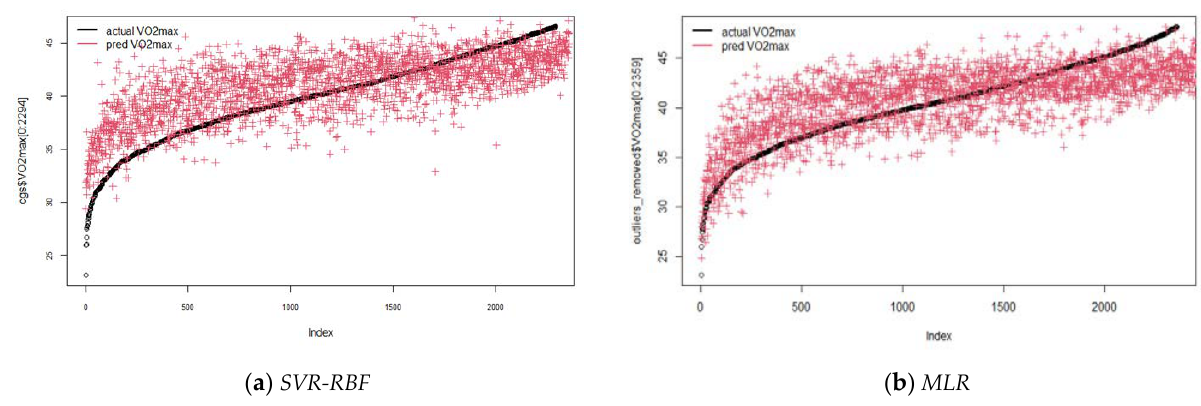
Figure 6. Scatterplots for actual and predicted values using SVR-linear ( a ) and MLR ( b ) for boys (tuned model).